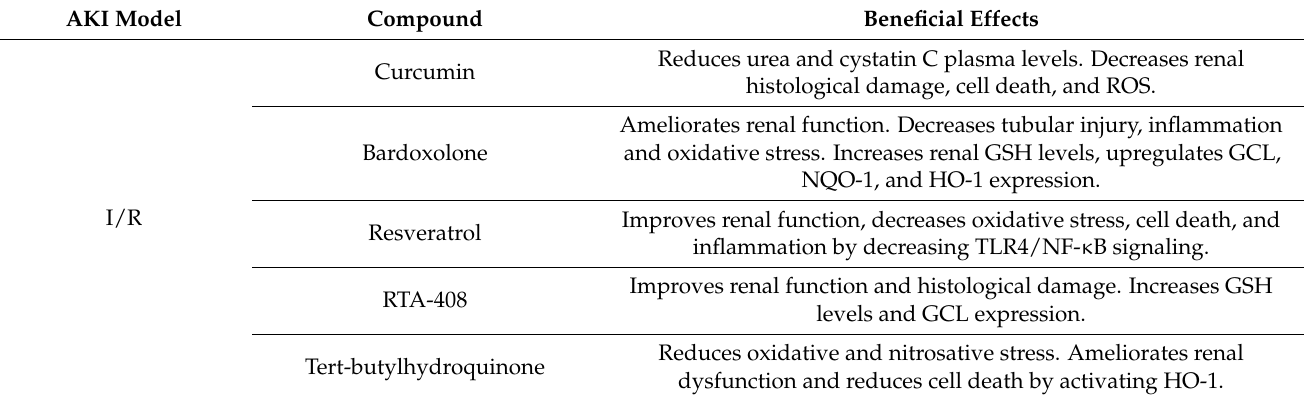
Table 2. Beneficial effects of Nrf2 inducers in experimental